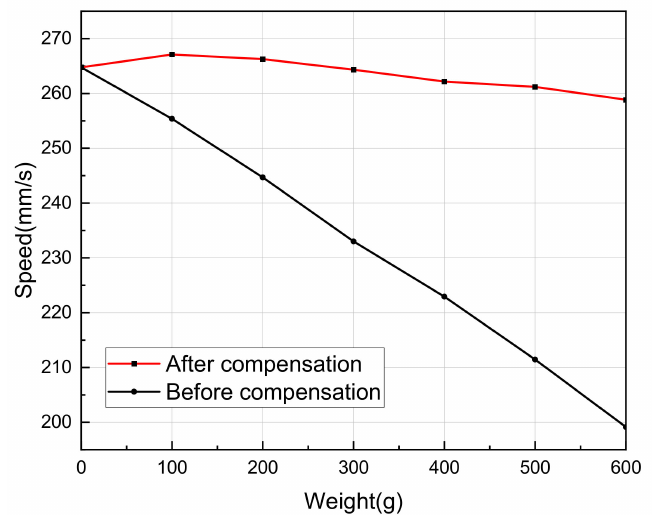
Figure 12. Speed of the linear ultrasonic motor under di ff erent